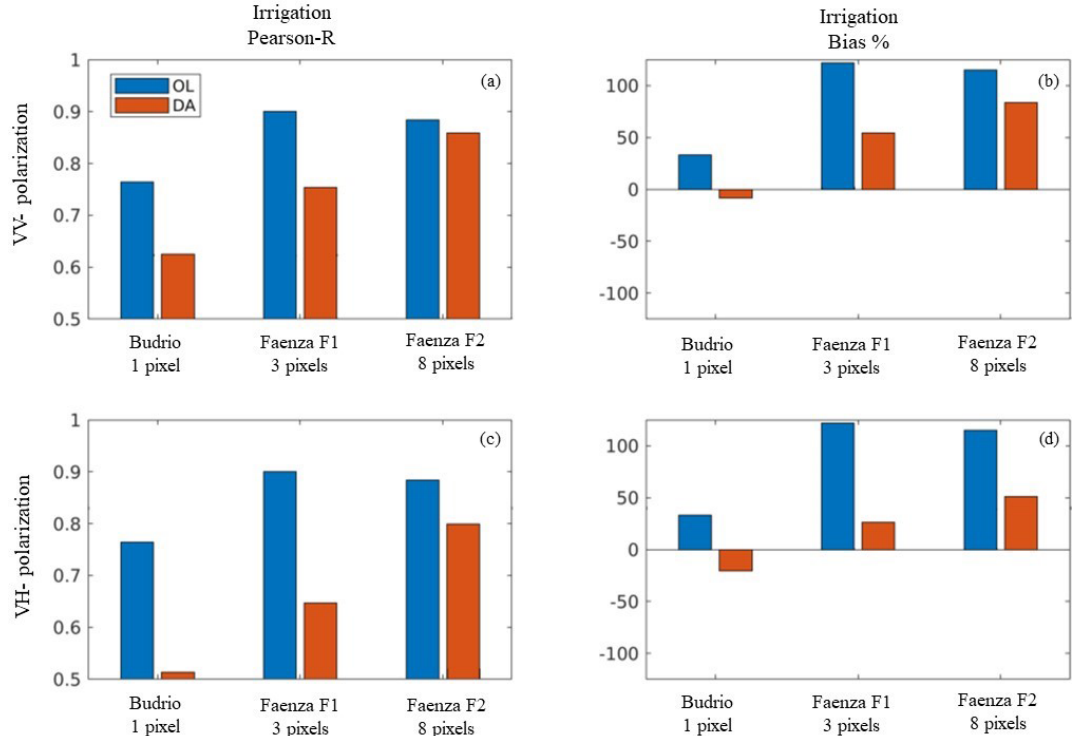
Figure 7. Evaluation results in terms of irrigation simulations for the three Italian test sites based on the extent of the fields in terms of LIS pixels. Blue bars refer to the OL run, while orange bars refer to the DA run. The Pearson R values are reported for (a) the Sentinel-1 γ 0 VV DA and (c) the Sentinel-1 γ 0 VH DA experiments. (b, d) Same as (a) and (c) but for percentage